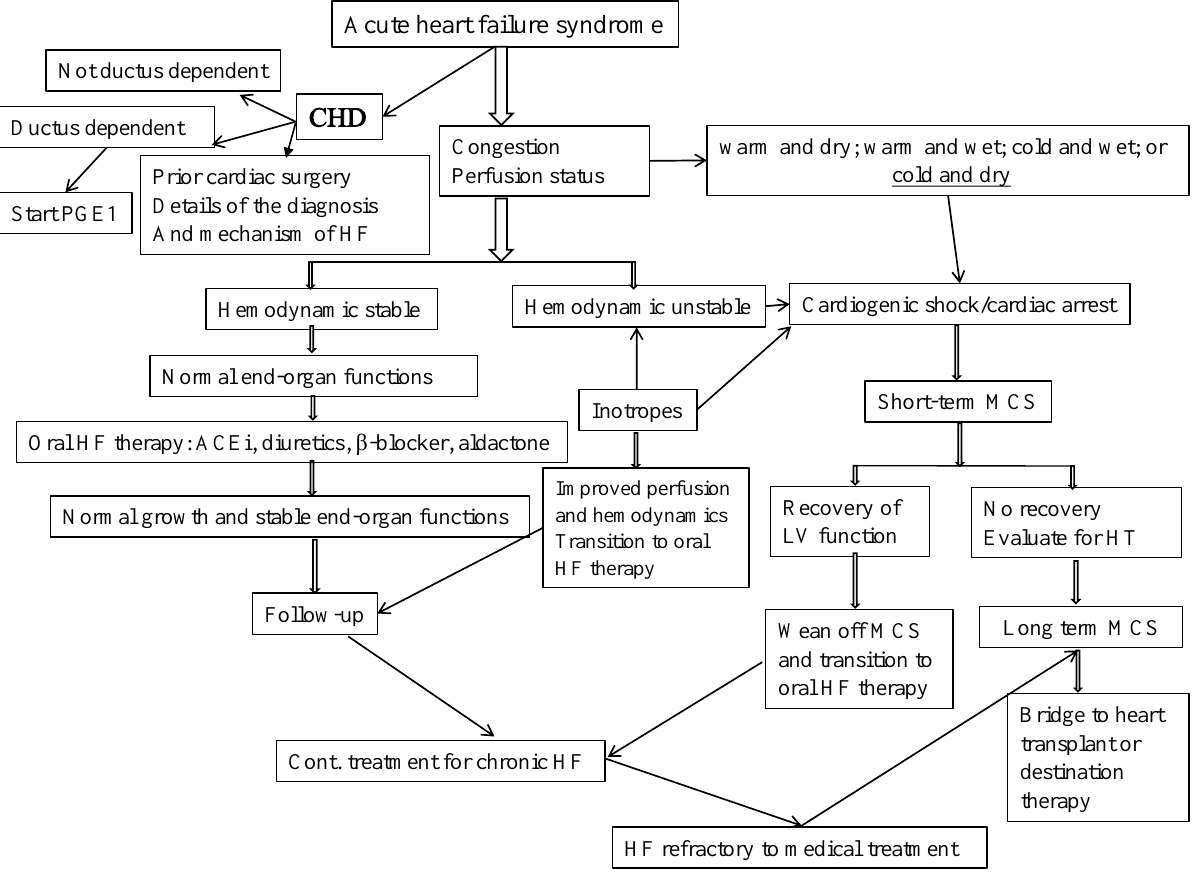
Figure 1. Approaches to acute HF in infants and children. (MCS: mechanical circulatory support; HF: heart failure; CHD: congenital heart disease; H/O: history of; PGE1: prostaglandin 1; ACEi: angiotensin-converting enzyme